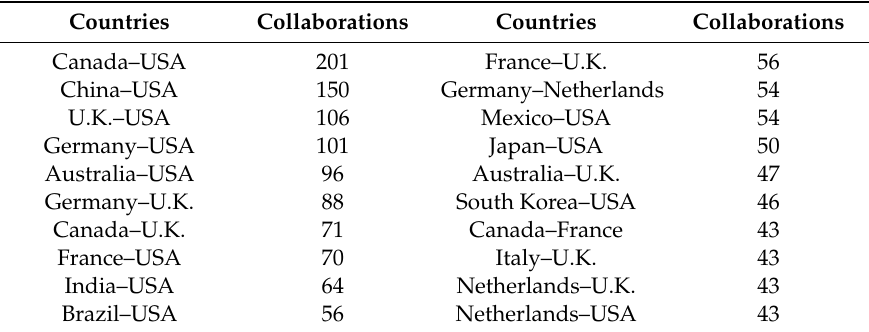
Table 3. Top 20 international research cooperation.